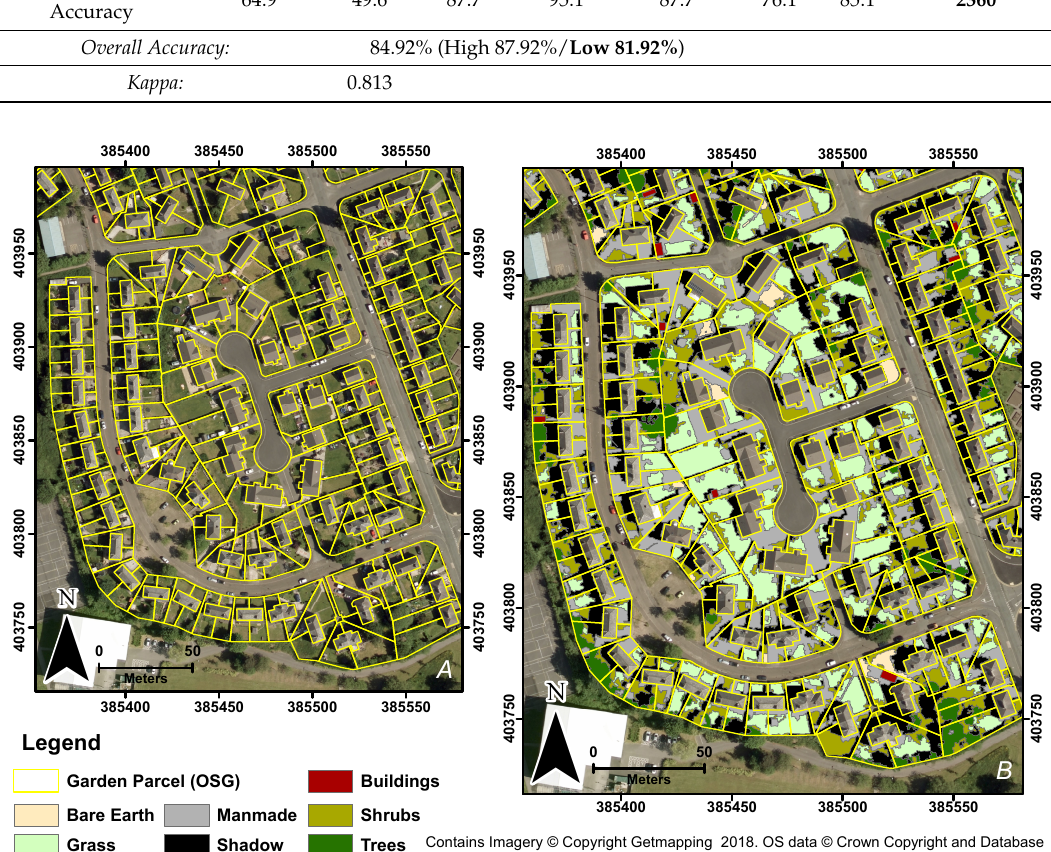
Figure 6. Example results of the image classification ( A ) original image; ( B ) classification